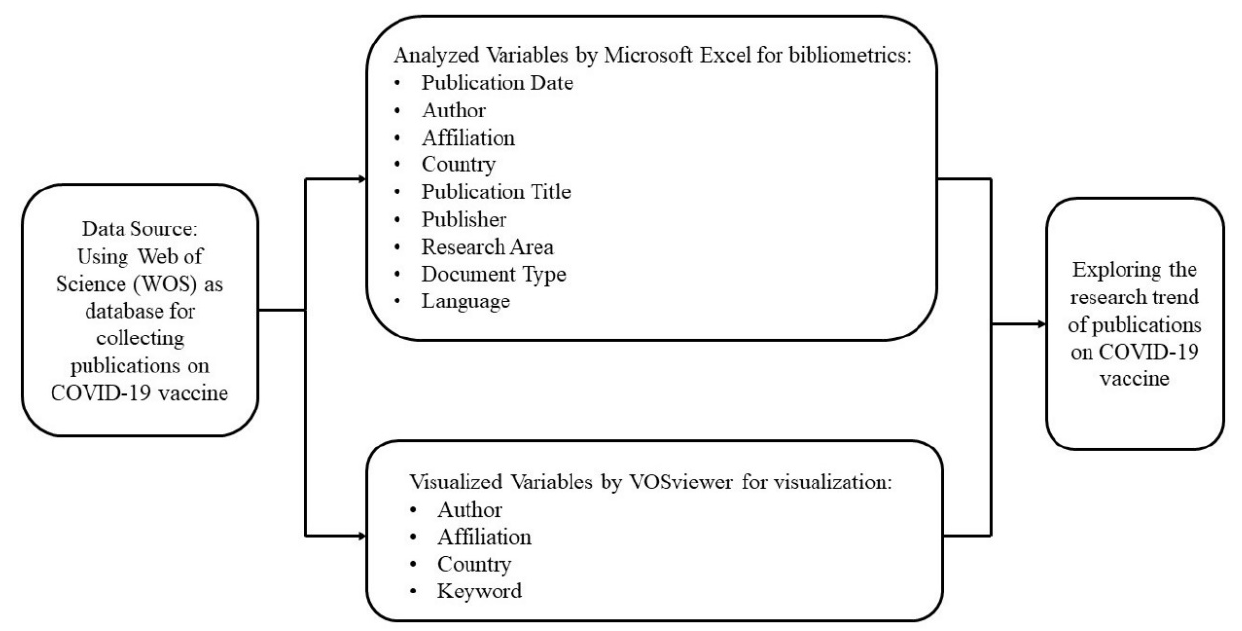
Figure 1. The conceptual framework in this study.